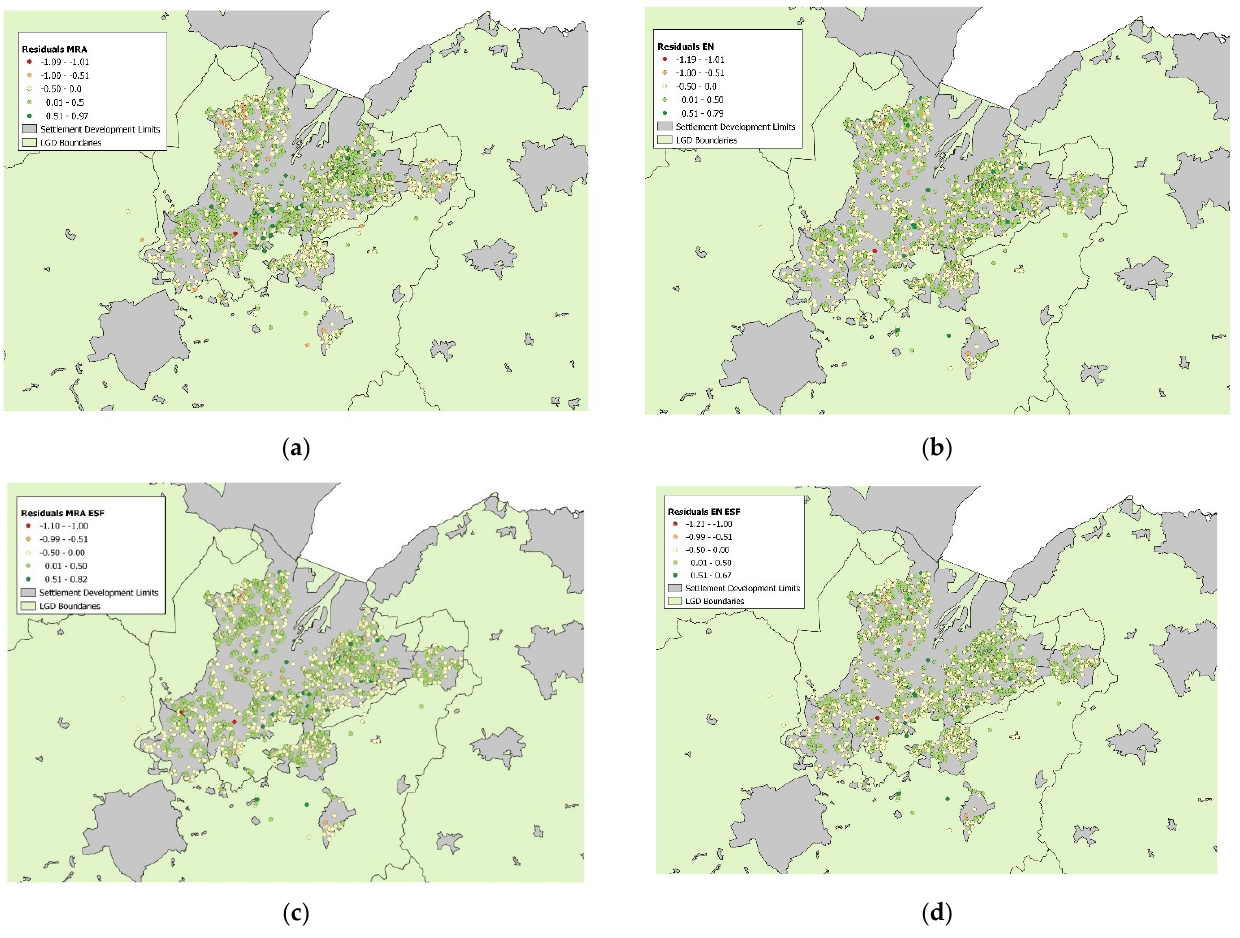
Figure 4. Residual errors across the different models. ( a ) MRA model. ( b ) Elastic-net model. (c ) MRA ESF model. ( d ) Elastic-net ESF